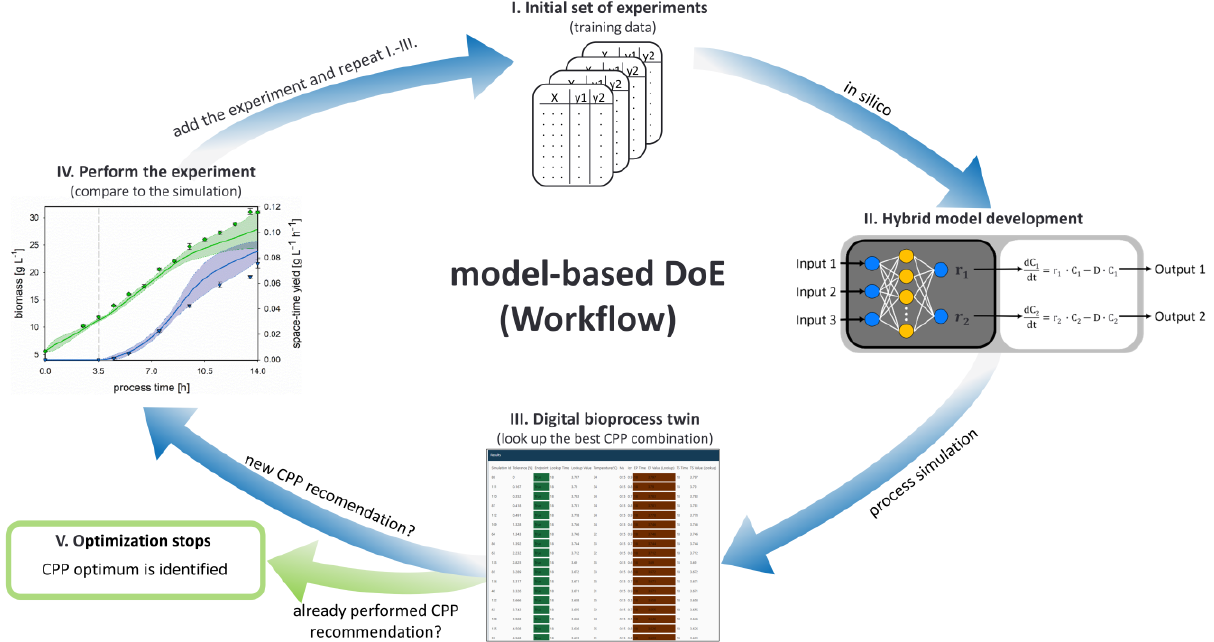
Figure 1. Schematic workflow of optimizing the space-time yield using model-based DoE. Starting with an initial set of experiments from a given design space (I), a hybrid model is developed (II) and transferred to a digital twin environment. Based on the hybrid model, the digital twin simulates all experiments of the design space and recommends the best CPP combination in the design space to obtain the maximum value of the variable of interest (space-time yield) (III). In the case of a new CPP recommendation, the experiment is performed, added to the training data, and utilized to re-train the hybrid model with the new process information (IV). Once no new CPP recommendation is obtained, the digital twin identifies the best CPP combination to maximize the space-time yield and the optimization stops (V).